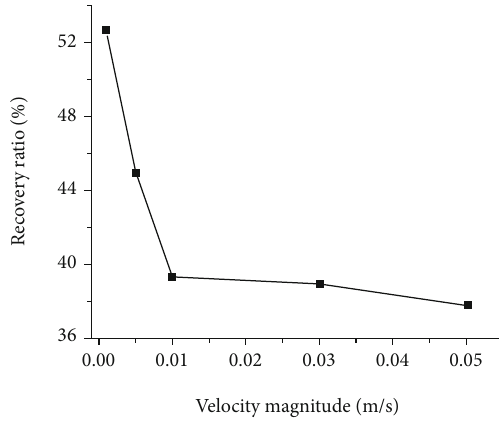
Figure 7: Recovery e ffi ciency versus injection